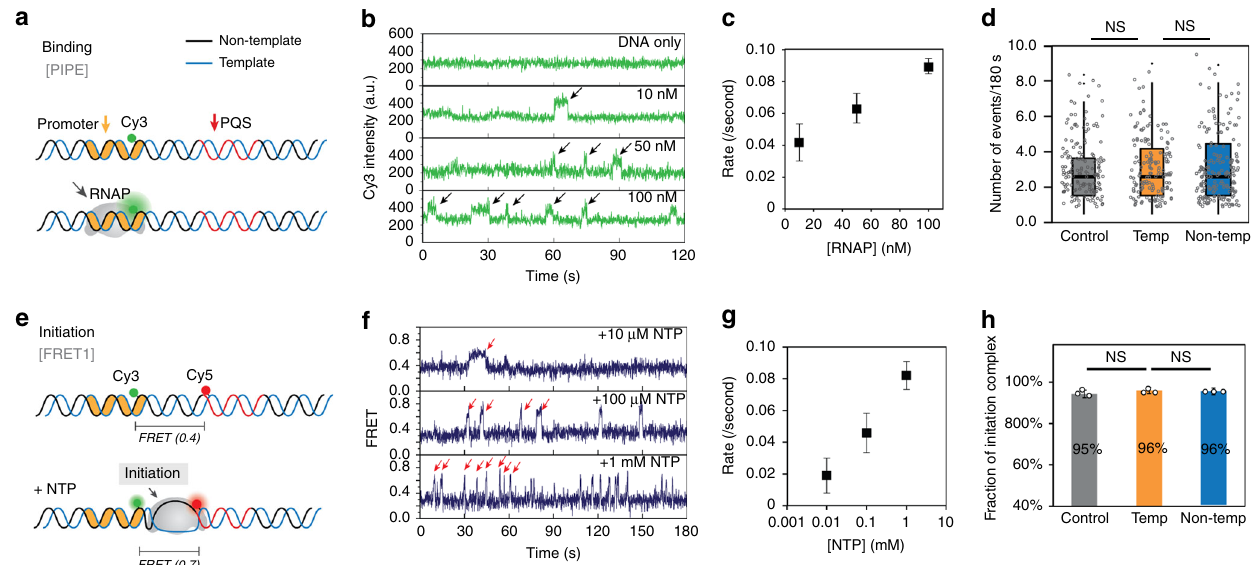
Fig. 3 PQS orientation has no effect on binding and initiation. a Single-molecule PIFE assay to study the RNAP binding. b As shown in a , the binding of RNAP to promoter induces Cy3 PIFE signal indicated by a black arrow. Each trace represents one example of protein titration from 0, 10, 50, and 100 nM. c The RNAP binding rate is calculated from the frequencies of Cy3 PIFE signal. d The number of events in one trace (3 min) averaged from more than 150 traces. e Single-molecule FRET assay to study transcription initiation. Opening the transcription bubble (gray arrow) causes a jump transition of FRET from 0.4 to 0.7. f As shown in e , the initiation event can be detected as a FRET burst (red arrow). Each trace represents one example of NTP titration from 10 µ M, 100 µ M, and 1 mM. g The initiation rate is calculated by the frequencies of FRET bursts. h Fraction of initiation is calculated from the population of binding and initiation in the total events. For c , g , data are presented as mean ± SEM, obtained as described in “ Methods. ” Numbers of independent measurements are from 40 to 479. Exact mean values are provided in Supplementary Tables 3.3 and 3.5. Raw data points are provided as a Source Data fi le. For d , numbers of counts from individual traces were plotted; the bottom and top of the box present the fi rst and third quartile, respectively; the band inside the box shows the mean and the whiskers show the upper and lower extremes. Statistical analysis performed by two-sided unpaired t -test shows no signi fi cance (NS). Exact P -values are provided in Supplementary Table 3.4; raw data points are provided as a Source Data fi le. For h , data are presented as mean ± SEM of n = 3 independent experiments. Statistics analysis performed by one-sided Pearson ’ s χ 2 -test shows no signi fi cance (NS). Exact P -values are provided in Supplementary Table 3.6. How to distinguish binding and initiation is described in Supplementary Fig. prominent impact in the PQS-NT (Fig. 5h, i). Furthermore, the fraction of the up-shifted DNA corresponding to R-loop on EMSA gel showed a linear correlation with the fraction of 0.1 FRET peak in the smFRET assay (Fig. 5g and Supplementary Fig. 4d, e), con fi rming that they both represent the R-loop. Therefore, our results indicate that the enhanced transcription of PQS-NT arises from the higher R-loop formation than in control and PQS-T. Transcription is enhanced by successive R-loop formation .